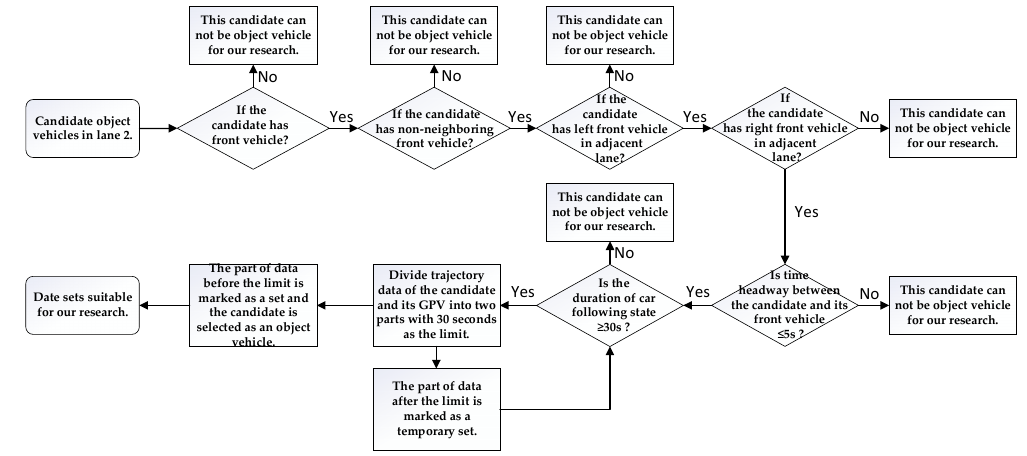
Figure 2. Data filtering progress of the US101 data set.